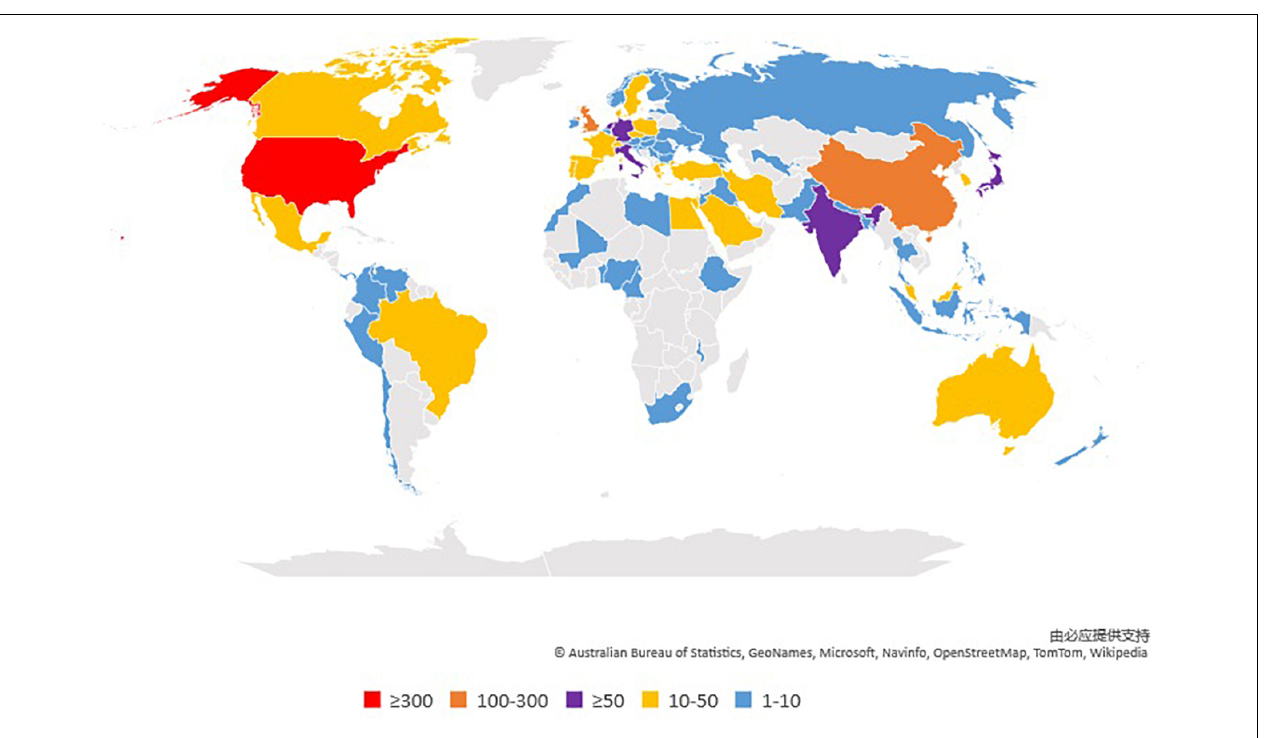
FIGURE 7 | World diagram of total country output based on